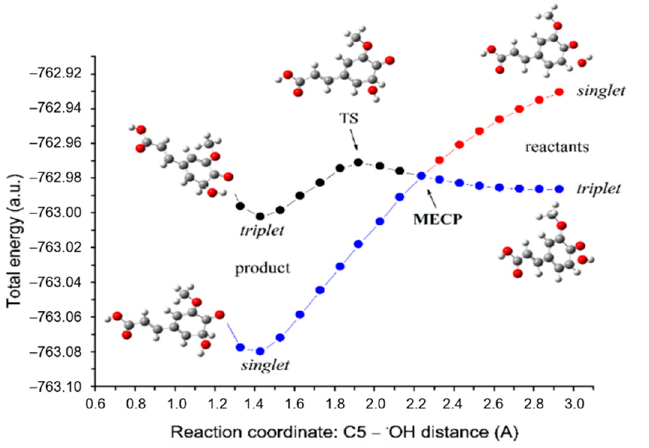
Figure 3. Energy profiles for RRC pathways of the C5 site of FAPR with the • OH radical. Red and black lines indicate singlet and triplet states, respectively. The proposed reaction path is denoted by the blue line.